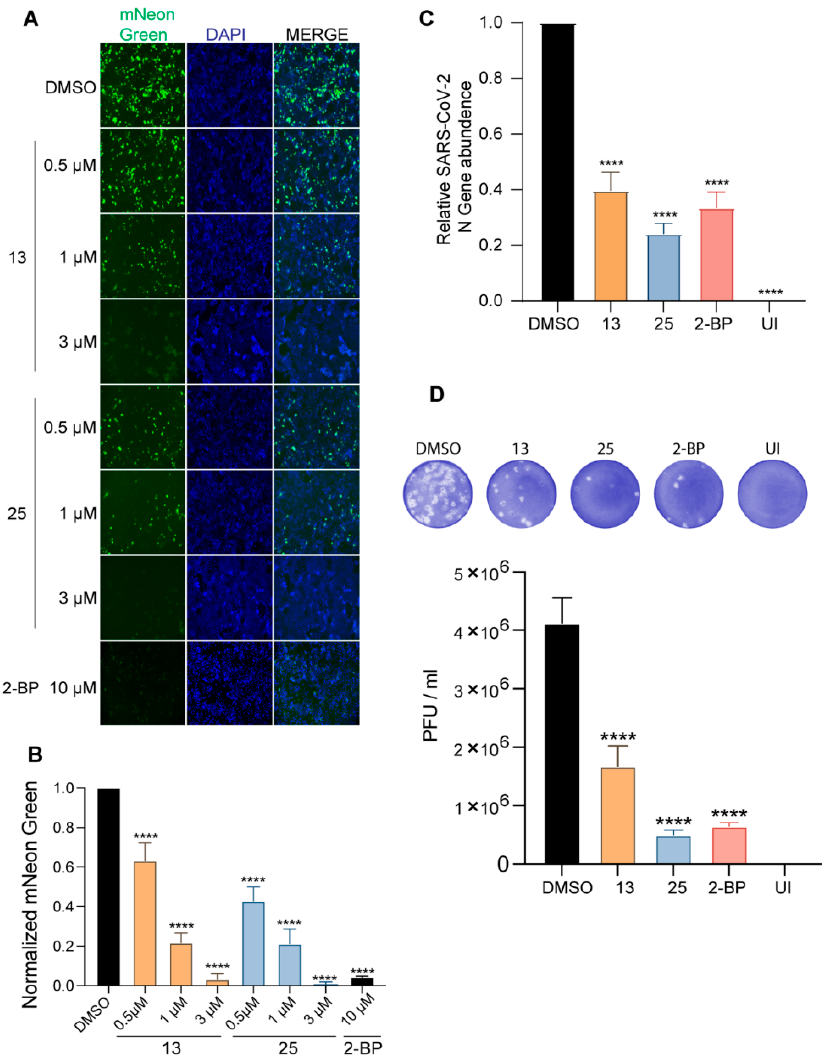
Figure 8 . Compounds 13 and 25 inhibit SARS-CoV-2 infection. ( A ) Caco-2 cells were pretreated with the indicated concentrations of compounds 13 and 25 for 12 h and then infected with icSARS-CoV-2-mNG (MOI 0.1). Post-infection, the cells were continued to be incubated in the presence of the respective compound dilutions. The cells were fixed 72 h later and nucleus stained with DAPI and visualized under a fluorescence microscope; 10 μ M 2-BP was also included in this experiment. ( B ) mNeonGreen signal from ( A ) was quantitated (6 fields from each experiment), normalized to DAPI and plotted to show the effect of the respective concentrations of the DHHC9 PAT inhibitors on icSARS-CoV-2-mNG infection. Data shown are averages of the results of at least three independent experiments ± SD (One-Way ANOVA). ( C ) Caco-2 cells were pretreated with compounds 13 (3 μ M), 25 (3 μ M) or 2-BP (10 μ M) for 12 h and then infected with SARS-CoV-2 (MOI 0.1). Post-infection, the cells were continued to be incubated in the presence of the respective compound dilutions. The virus-containing supernatants were collected 72 h later and used to infect Vero-E6-ACE2 cells. The Vero-E6-ACE2 cells were collected 24 h after this infection, RNA extracted, and the SARS-CoV-2 N gene quantified using RT-qPCR. UI represents uninfected. ( D ) Same experiment as in C, except that the virus titers in the supernatant were estimated by plaque assay on VERO-ACE2-TMPRSS2 cells. All data shown are averages of the results of at least three independent experiments ± SD **** p < 0.0001 ( t -test).